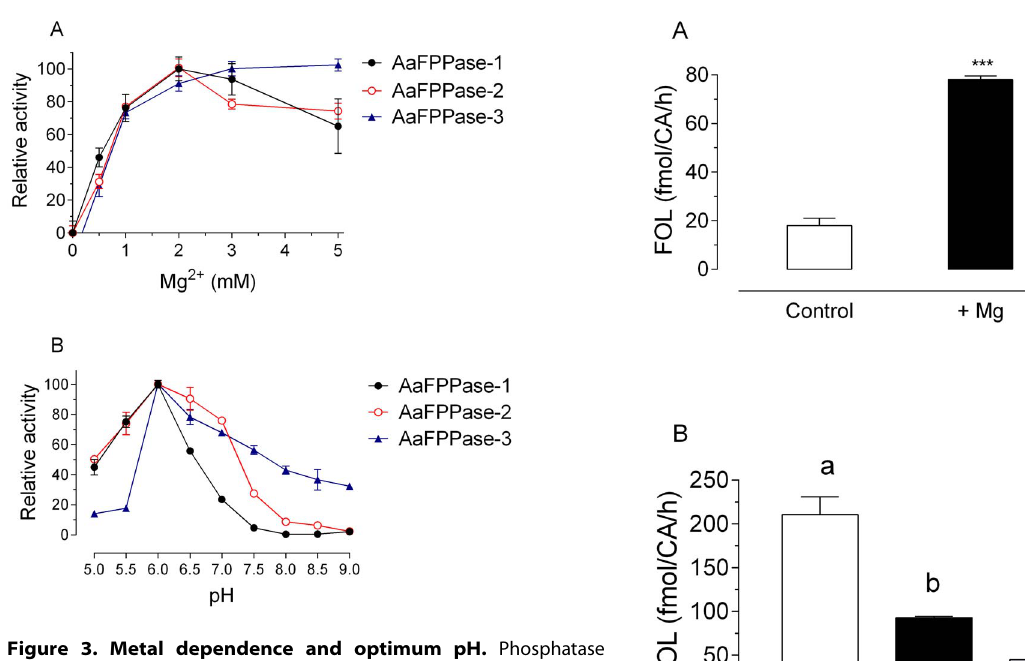
Figure 3. Metal dependence and optimum pH. Phosphatase activity was measured using p -NPP. A) Magnesium dose-dependent increases of activities. B) Optimum pH determinations. Three different buffers were used: Sodium acetate at pH 4.5 to 5.5, MES at pH 5.5 to 7 and Tris at pH 7 to 9. Each value represents the means 6 S.E.M. of three replicate assays. Relative activity is defined as a percentage of the